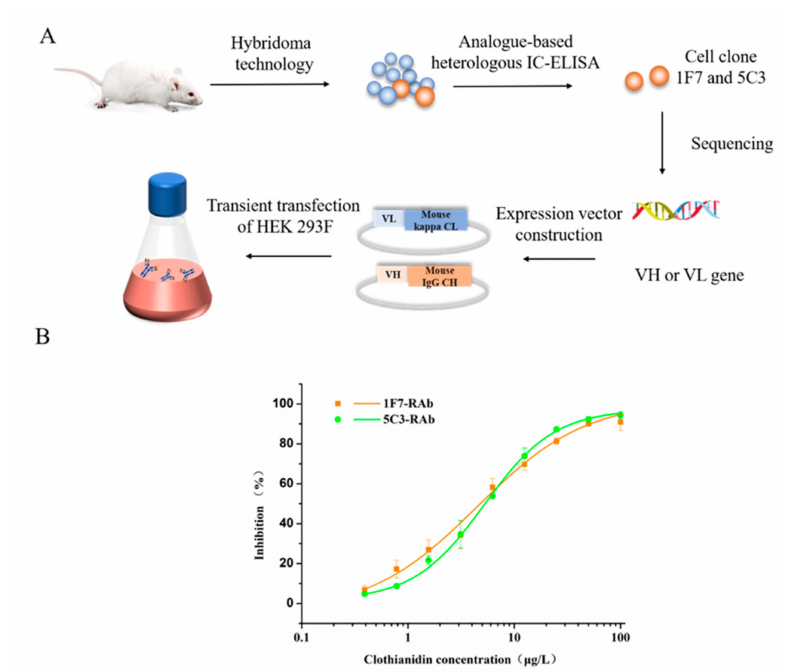
Figure 2. Cloning variable region genes of antibody from hybridoma for developing full-length IgG RAbs. Scheme of the production of full-length IgG RAbs ( A ). The inhibition curves of clothianidin were measured by antibodies based on heterologous ic - ELISAs ( B ). IMI-H-OVA-based heterologous ic - ELISAs for 1F7-RAb (1.25 µ g/mL of IMI-H-OVA). THC-H-OVA-based heterologous ic - ELISAs for 5C3-RAb (5 µ g/mL of